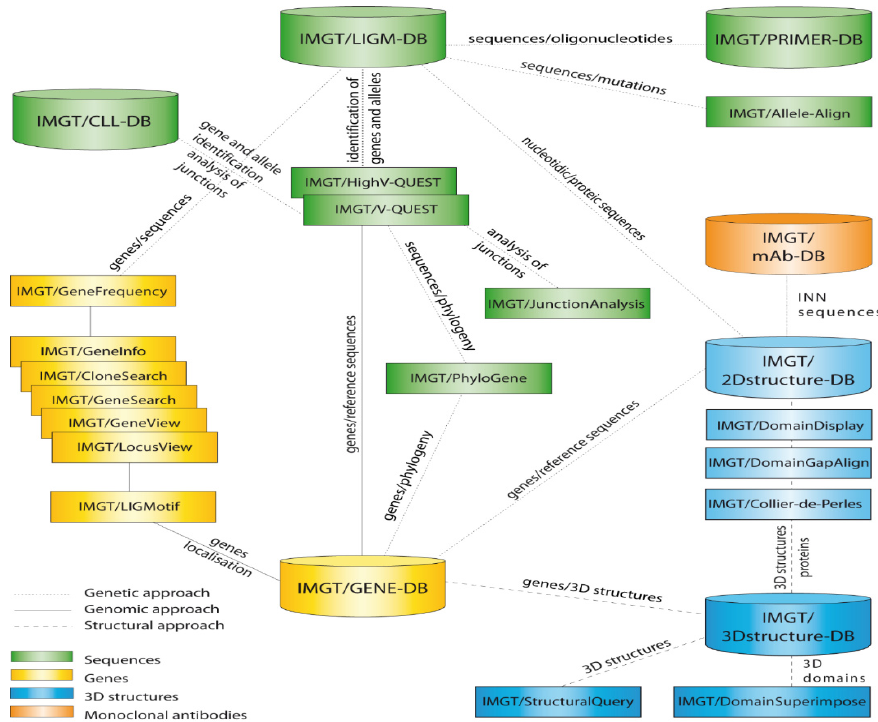
Figure 1. IMGT ® , the international ImMunoGenetics information system ® , http://www.imgt.org (accessed on 22 February 2022) [1,5]. IMGT ® comprises seven IMGT databases (shown as cylinders), seventeen online IMGT tools (shown as rectangles) and the IMGT Web resources (more than 25,000 pages, the ‘IMGT Marie ‐ Paule page’) (not shown), for genes (in yellow), sequences (in green) and structures (in blue), all available from the IMGT ® Home page. IMGT/mAb ‐ DB has been online since 4 December 2009. IMGT/HighV ‐ QUEST for next ‐ generation sequencing (NGS) high ‐ throughput sequence analysis, created in October 2010, has been available on the web since 22 November 2010. (With permission from M-P. Lefranc and G. Lefranc, LIGM, Founders and Authors of IMGT ® , the international ImMunoGeneTics information system ® , http://www.imgt.org) (accessed on 22 February